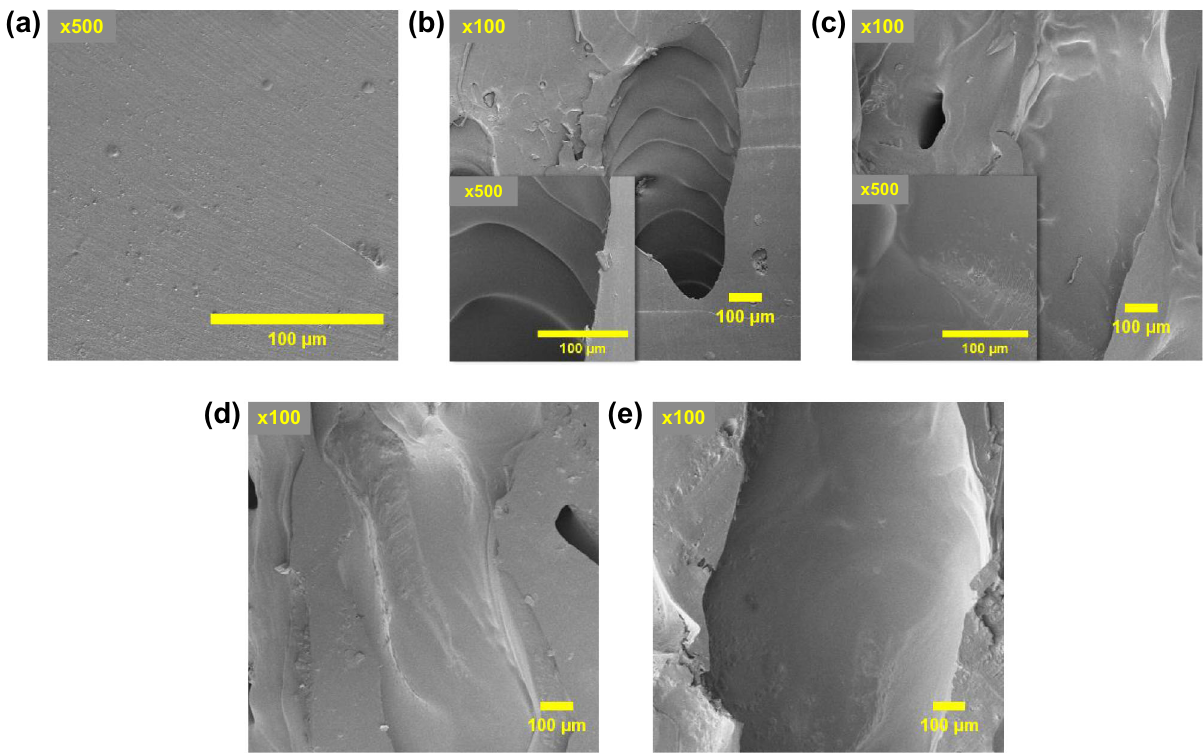
Fig. 4 Field-emission scanning electron microscope (FE-SEM) images of the produced DCPD/AC foams. a Neat DCPD solid, ( b ) DCPD/0.5 wt% AC, ( c ) DCPD/1 wt% AC, ( d ) DCPD/2 wt% AC, and ( e ) DCPD/4 wt% AC at ×100 – 500 magni fi